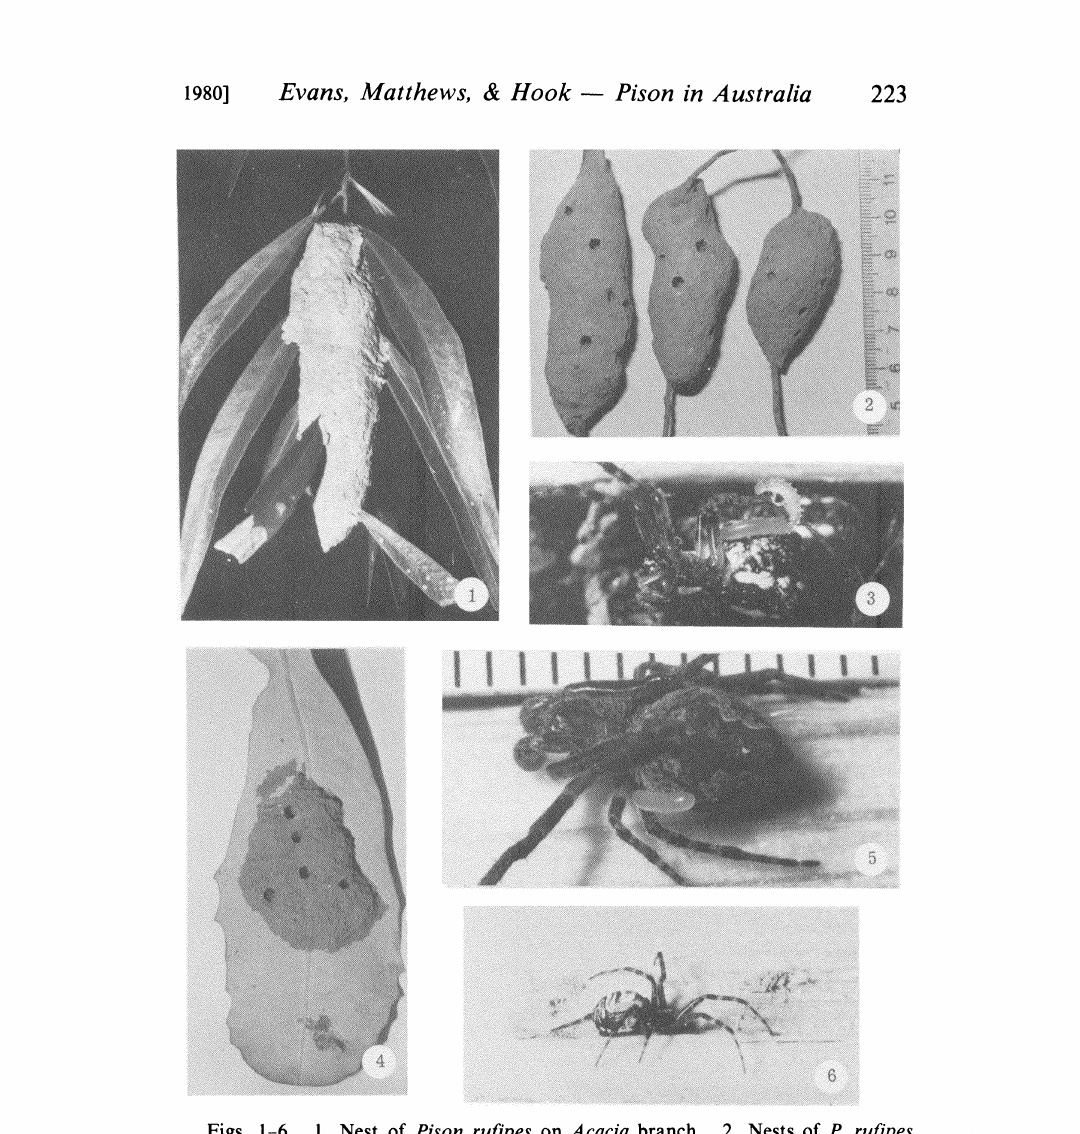
Figs. 1-6. 1. Nest of Pison rufipes on Acacia branch. 2. Nests of P. rufipes attached to pendant roots. 3. Egg of P. marginatum on prey, bearing a parasitoid larva. 4. Nest of P. ignavum on Banksia leaf. 5. Egg of P. spinolae on prey. 6. Egg of P. marginatum on